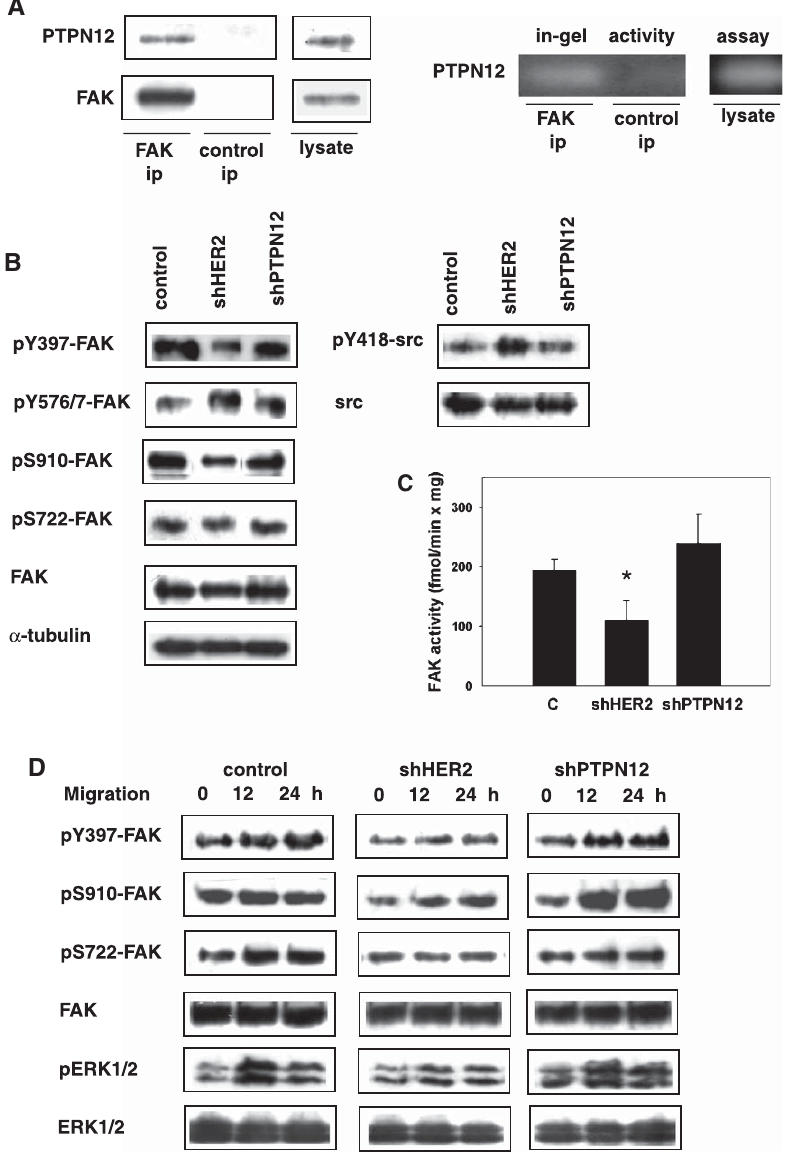
Fig. 4. FAK regulation in cells carrying silenced HER2 or silenced PTPN12. (A) FAK and PTPN12 association. Anti-FAK and control immunocomplexes were obtained form SKOV-3 cells and assayed for the presence of PTPN12 and FAK by immunoblot, and for the phosphatase activity of PTPN12 by in-gel assay (further described in the Methods section). PTPN12, FAK and PTPN12 activity detected in cell lysates are also shown. The data are representative of 3 independent experiments. (B) FAK activation. Lysates prepared from HER2-silenced and PTPN12-silenced cells as well as control cells (carrying the empty vector) were used to immunodetect the phosphorylation of FAK at Y397, Y576/577, S910 and S722, FAK, the phosphorylation of Y416 of src, src and (cid:2) - tubulin. The data are representative of several independent experiments. (C) FAK kinase activity. FAK was immunoprecipitated from lysates as in B and the kinase activity was assayed using the substrate poly-Glu-Tyr, as further described in the Methods section. Average ± SEM of 3 experiments. Statistical analysis (Student’s t test): ∗ p <0.05. (D) FAK and ERK1/2 activation in migrating cells. Lysates prepared from cells induced to migrate in a wounded area (as in Fig. 1B) and collected at the indicated time points were used to immunodetect the phosphorylation of FAK at Y397, S910, S722 and pERK1/2 as well as FAK, ERK1/2 and (cid:2) -tubulin. The data are representative of 3 independent